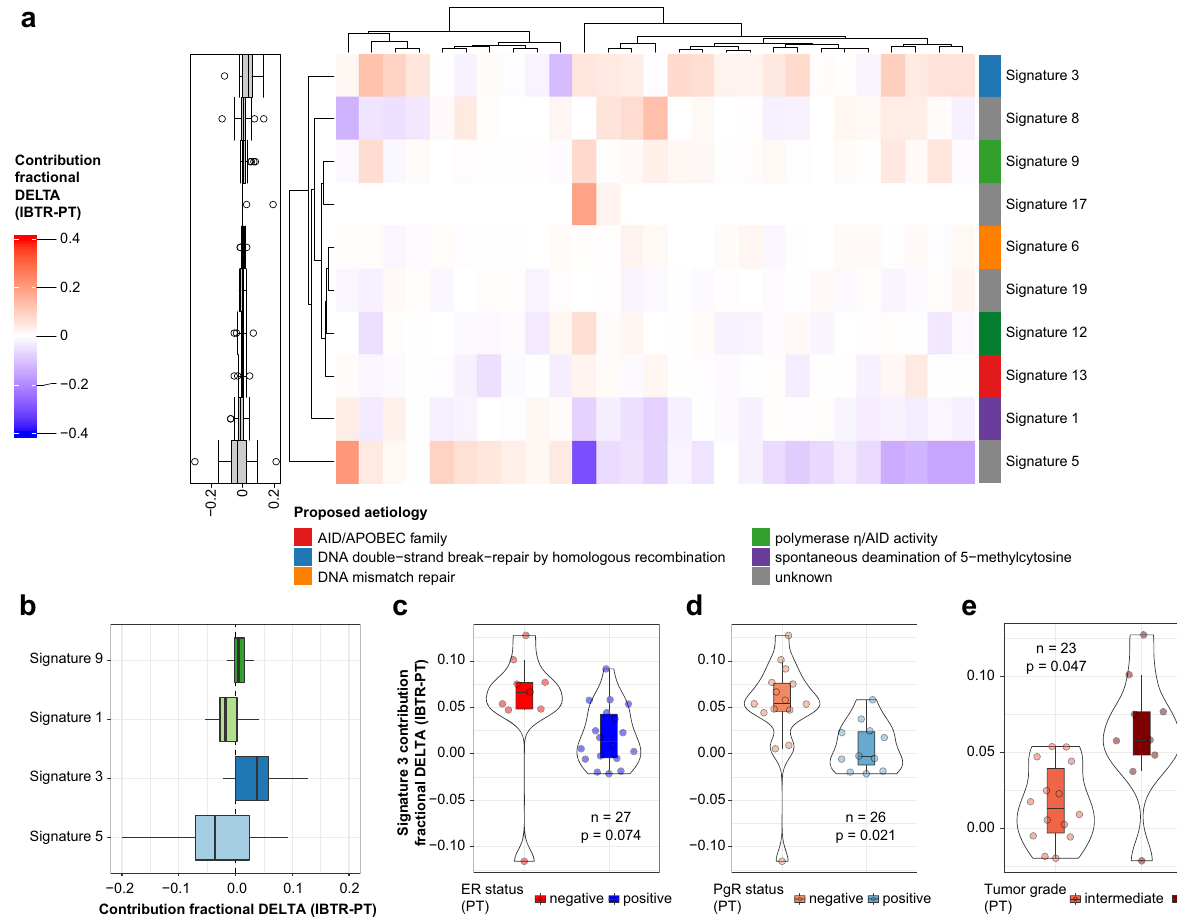
Fig. 2 Shift of mutational signature contributions. We evaluated the contribution of the 30 COSMIC mutational signatures within our samples (PT and IBTR subsets). Contribution fractional delta was then calculated as a measure of mutational process evolution for each PT-IBTR pair. Panel a displays hierarchical clustering of mutational contribution delta of the top 10 signatures with contribution gain and loss between paired samples (IBTR-PT; light gray boxes represent missing values). Boxplots left of the heatmap represent value distribution for each row. Panel b shows the top 5 signatures with contribution changes between primary and locally recurrent tumor pairs (excluding signature 17 due to contribution in only 2 samples). Signi fi cant associations between changes in mutational signature 3 contribution and clinical variables are depicted in c – e . Number of samples included in each test depends on availability of clinical data. Boxplots depict distribution of values as quartiles. Line at the center of each boxplot depict the median value. ER estrogen receptor, ERBB2/Her2 receptor tyrosine-protein kinase erbB-2, Ki-67 antigen Ki-67, IBTR ipsilateral breast tumor recurrence, IBTRFS IBTR-free survival, PgR progesterone receptor, PT primary